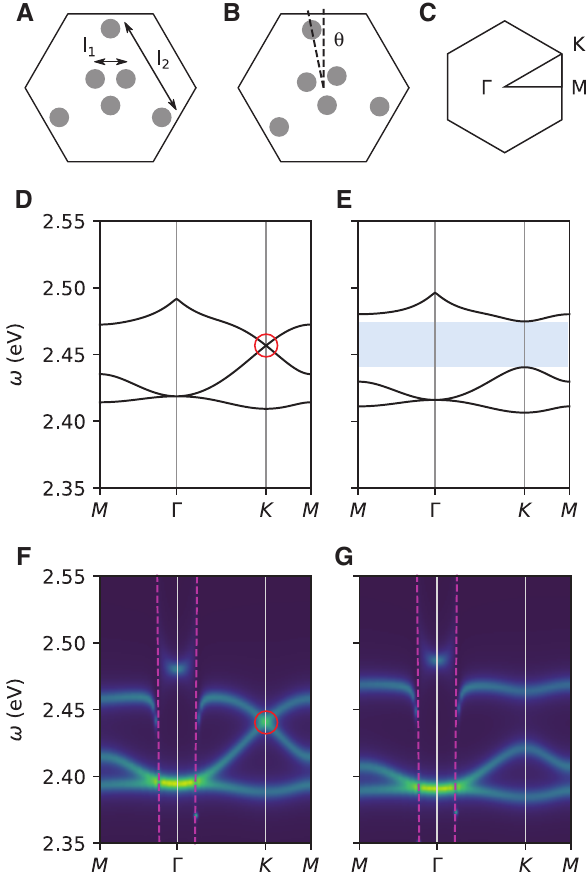
case. Figure 2: C 3 v (A) Unit cell with NP radius r = 5 nm and height h = 30 nm, internal spacing = 10 3 l nm, external spacing = 1 = 75 nm. (B) A θ = 0.1 rad rotation removes σ constant a 0 (D) Band structure, pre-perturbation. (E) Post-perturbation. (F and G) Spectral function: Higher-energy bands experience polariton-like splitting at the light line (magenta). Drude losses γ = 10